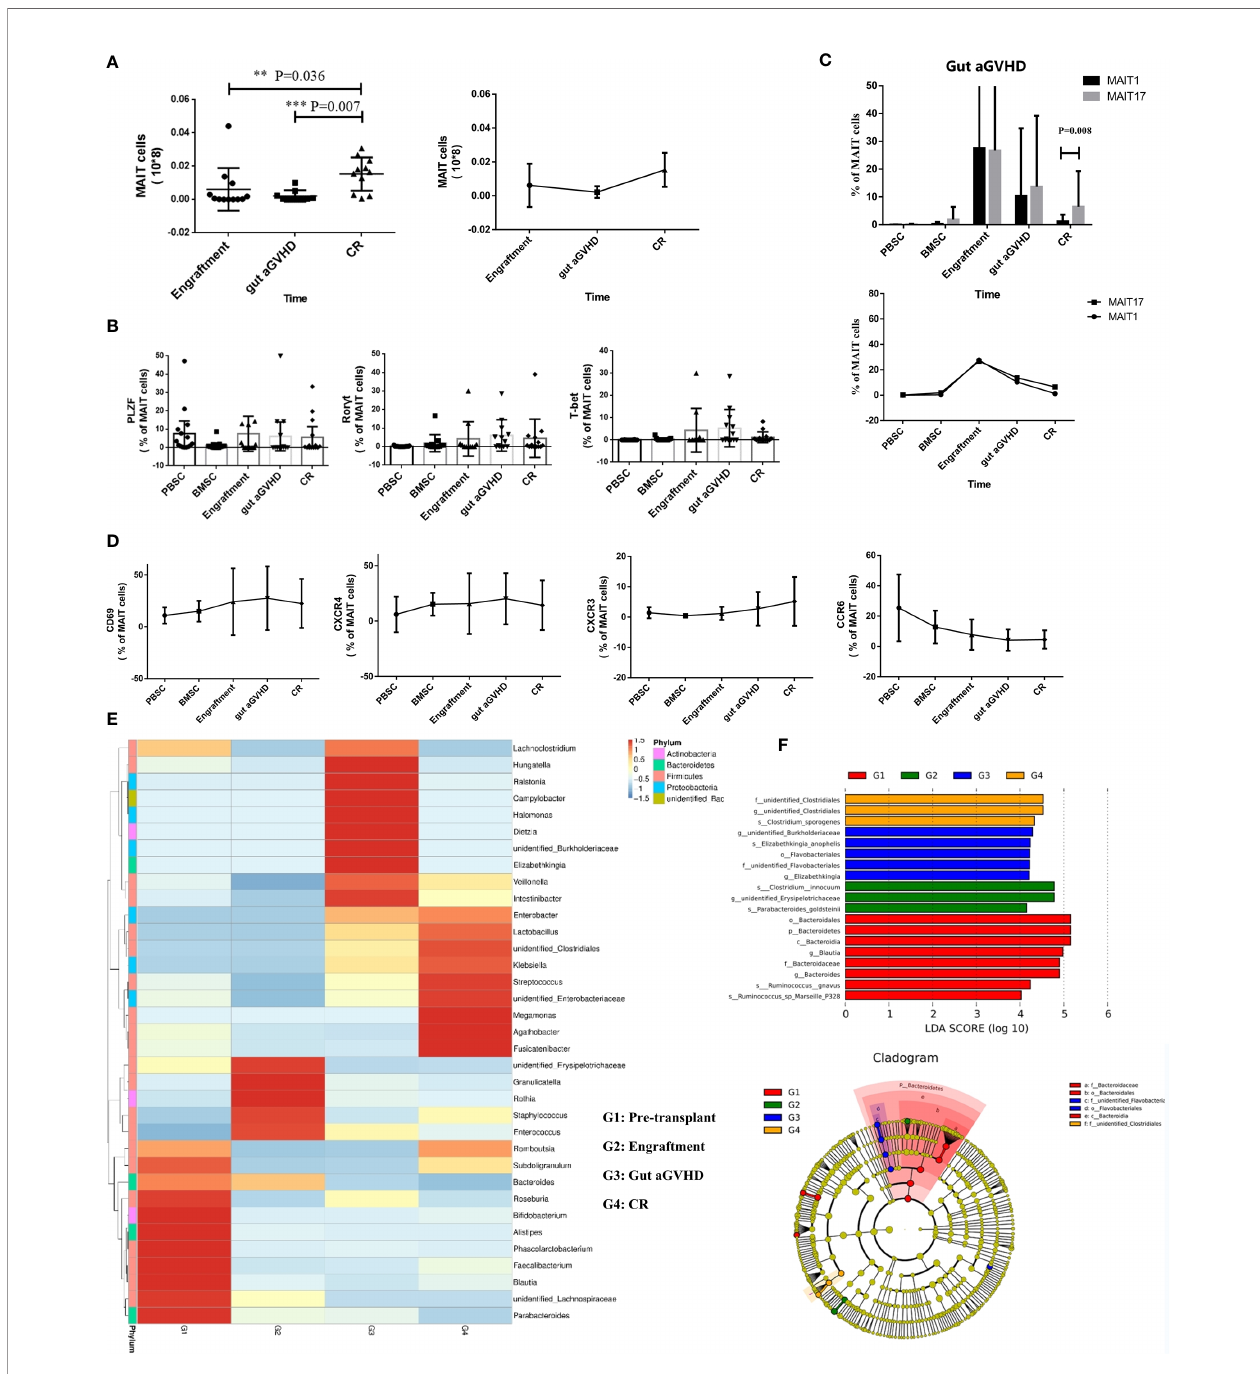
FIGURE 5 | Mucosa-associated invariant T (MAIT) cell functional changes in 16 gut acute graft-versus-host disease (aGVHD) patients before and after the onset of gut aGVHD. (A) The changes of MAIT cell number at three posttransplant time points, namely, at the time of neutrophil engraftment, at the onset of gut aGVHD, and at the CR of gut aGVHD. (B) The changes of transcription factors PLZF, T-bet, and Ror g t in patients with gut aGVHD at different points. (C) Posttransplant comparison of MAIT1 and MAIT17 subsets based on the expression of transcription factors T-bet and Ror g t respectively in gut aGVHD patients. (D) The changes of activation markers and chemokine receptors in patients with gut aGVHD at different points. (E) Cluster heat map of species abundance at the genus level. (F) LDA score distribution histogram and cladogram. Levels of signi fi cances are given as p-values with *** ≤ 0.01 and ** ≤